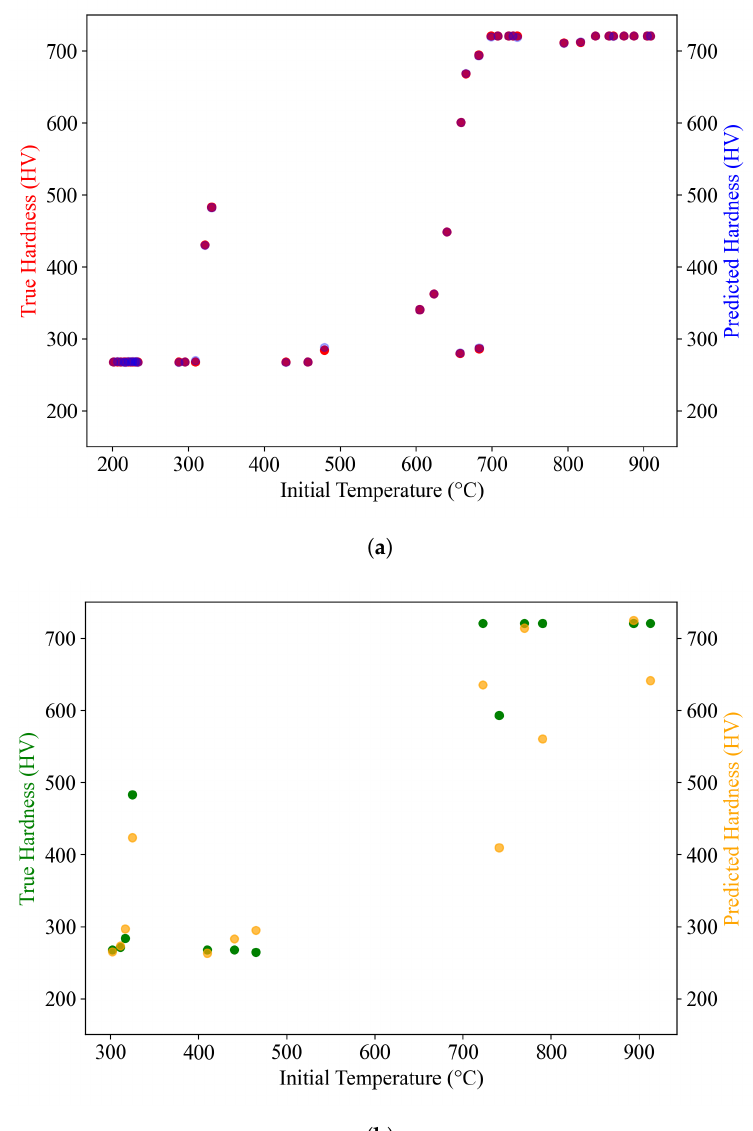
Figure 12. Comparison between the true and predicted hardness of the sensor 2 dataset: ( a ) training dataset with the predicted hardness (blue) over the ground truth (red). ( b ) testing dataset with the predicted hardness (yellow) over the ground truth (green). Both with respect to the initial temperature of the